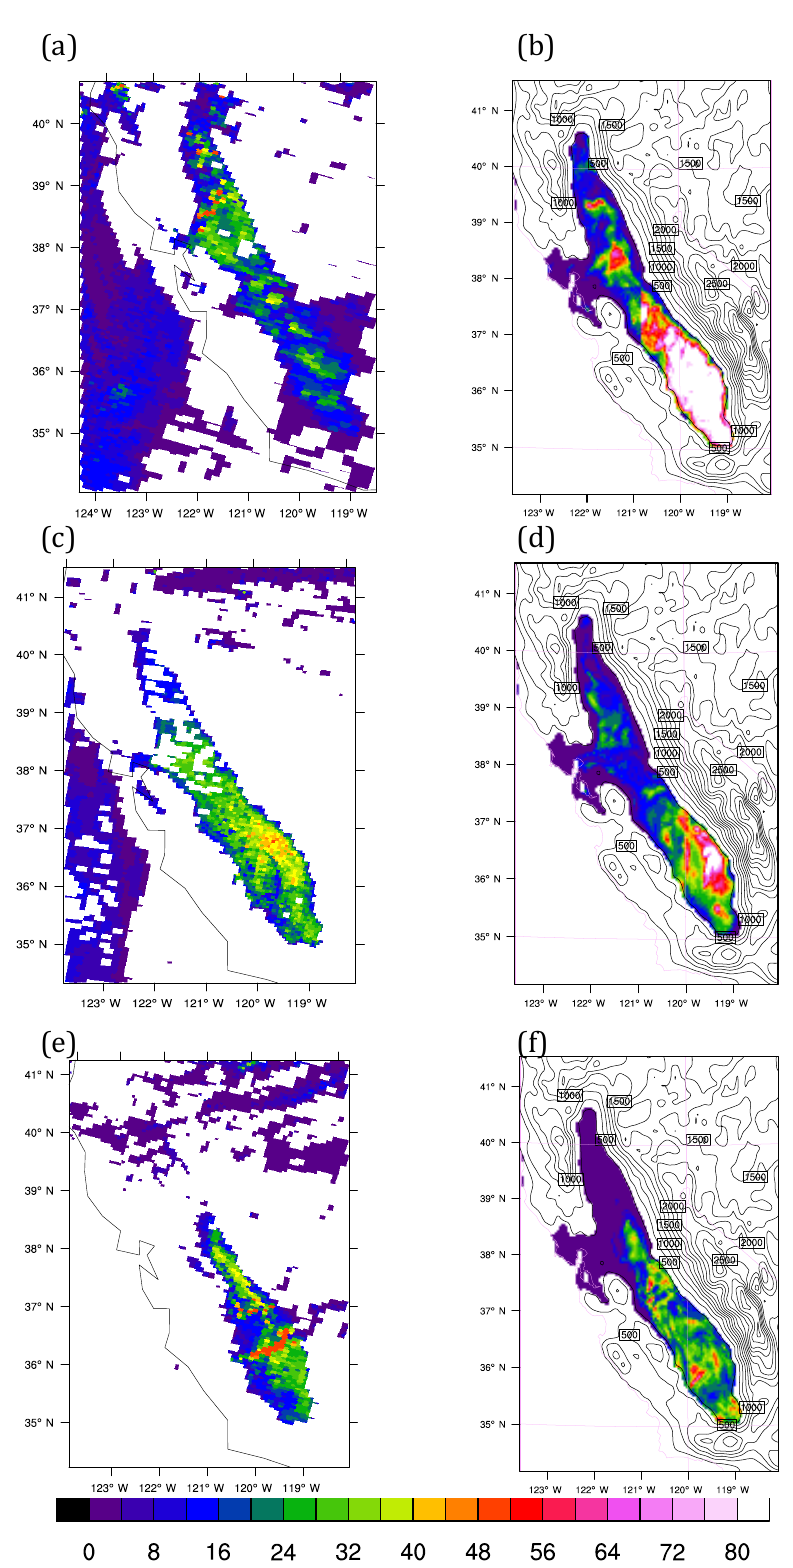
Figure 8. Same as Fig. 5 but for cloud optical thickness (COT)